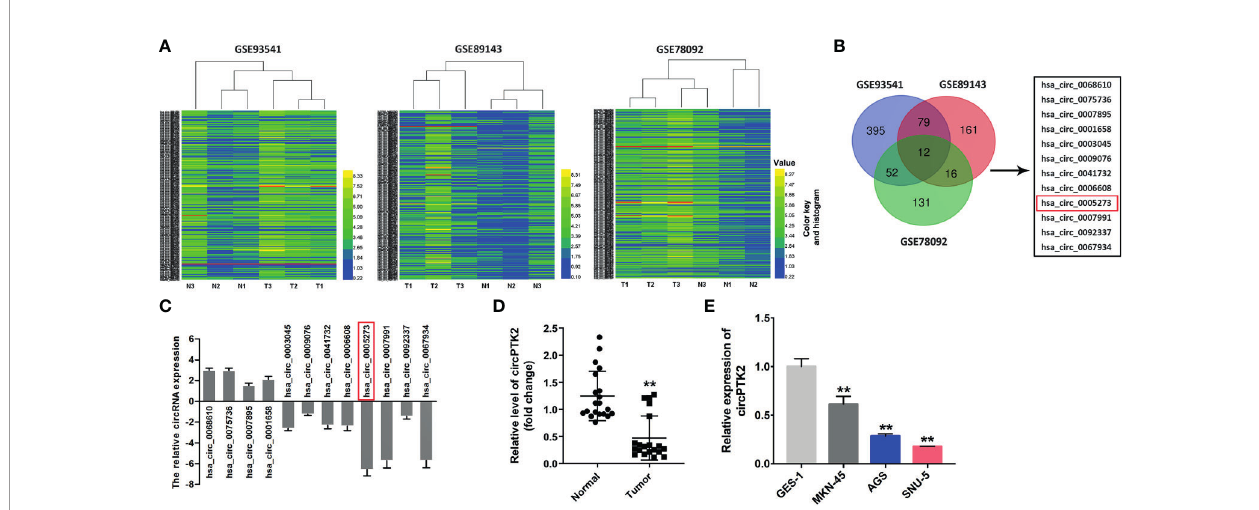
FIGURE 1 | Differential expression of circular RNAs (circRNAs) in gastric cancer. (A) The heatmaps of the DEcircRNA pro fi les in gastric cancer and compared normal tissues in GSE93541, GSE89143, and GSE78092. CircRNAs in yellow indicate overexpression; circRNAs in blue indicate reduced expression. (B) Venn diagram of overlapping DEcircRNAs from intersection of GSE93541, GSE89143, and GSE78092 datasets. (C) The expressions of circRNAs in tumor tissues ( n = 5) and normal tissues ( n = 5) were detected with RT-qPCR. (D) RT-qPCR analysis of circPTK2 level in tumor tissues ( n = 20) and normal tissues ( n = 20). (E) RT-qPCR analysis of circPTK2 level in AGS, MKN45, and SNU-5 cells. ** p < 0.01. The signi fi cance between two or more groups was analyzed by Student ’ s t -test or one-way ANOVA,